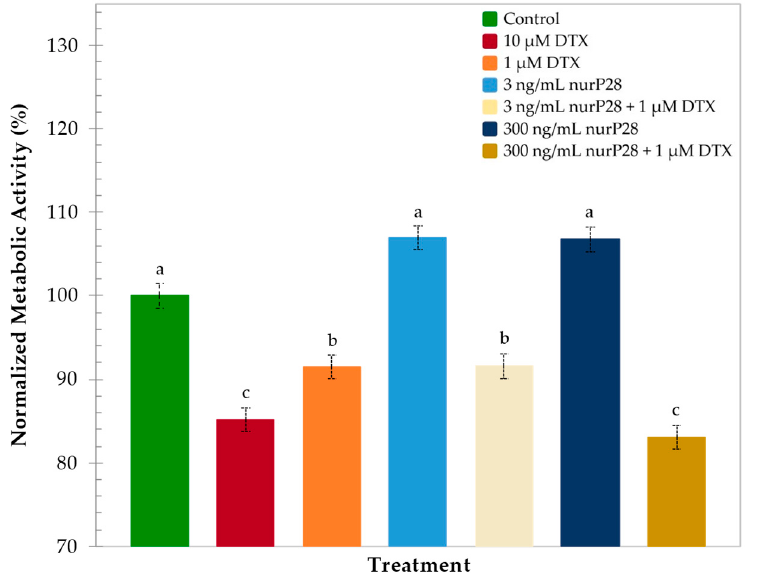
Figure 5. Normalized metabolic activity of breast cancer MCF7 monolayer cells after 48 h of exposure to nurP28 peptide alone and in combination with DTX. Results expressed as mean ± SD ( n = 3). The letters a, b and c indicate a statistically significant difference at p < 0.01. Bars with no common letters are significantly different.